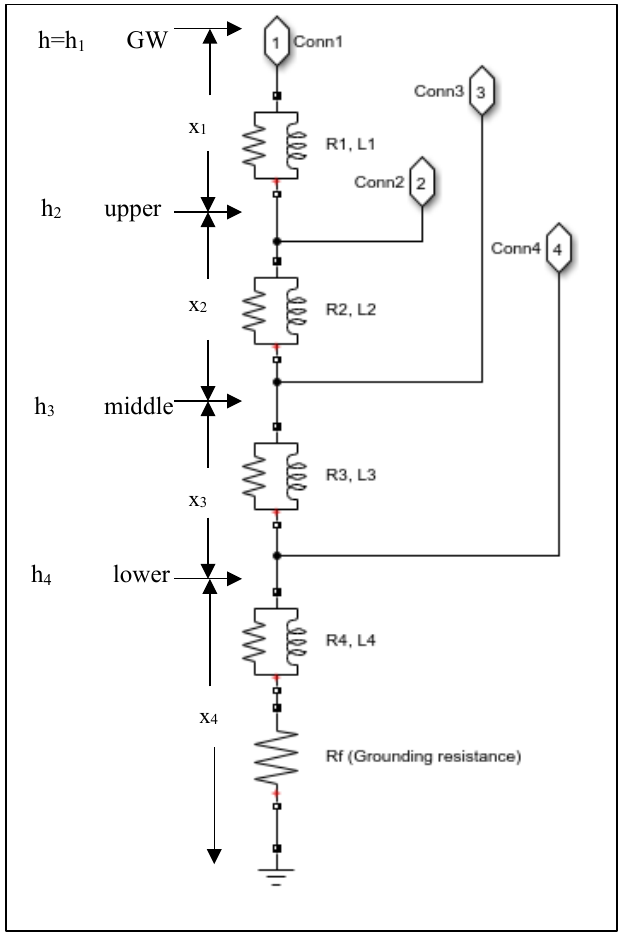
Figure 6. Multistory tower model in MATLAB [26].